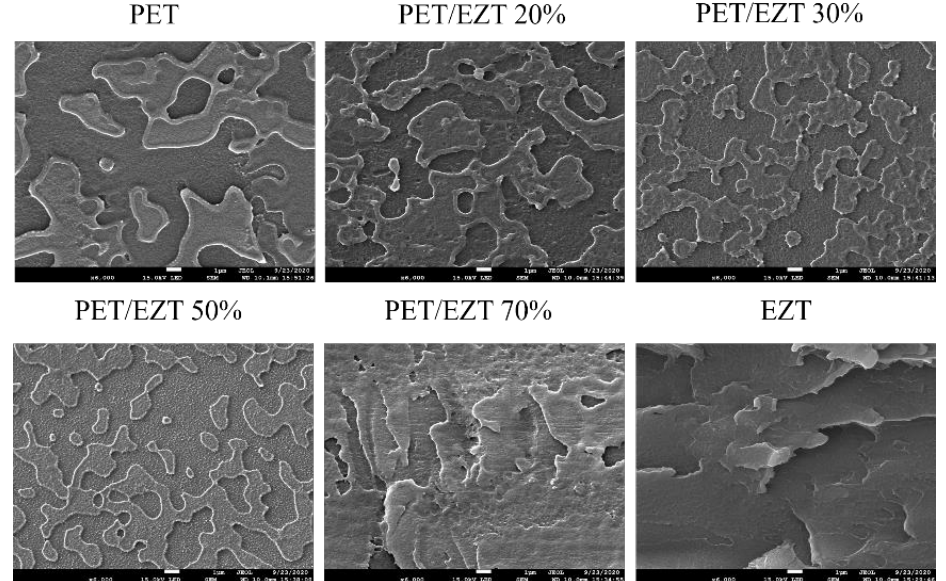
Figure 5. SEM micrographs of the cryo-fractured surface of PET/EZT samples. XRD analysis was performed to identify the crystalline structure of materials. Gen- erally, crystalline polymers represent a series of sharp peaks in the XRD patterns, and amorphous polymers exhibit a relatively broad halo. In contrast, semi-crystalline poly- mers show a superposition of crystalline reflections on an amorphous halo [48]. The XRD patterns of pristine PET, pristine EZT, and PET/EZT samples are shown in Figure 6. The pristine PET sample exhibited a characteristic broad peak and a weak peak at a diffraction angle (2θ) of 20.53° and 43.16°, which corresponded to the amorphous phase of the un- stretched PET sheet. This may have been related to a rapid cooling rate during the sheet forming process (injection molding). Therefore, long molecule chains did not have suffi- cient time to rearrange to form a crystalline phase at low temperatures. The pristine EZT sample also exhibited a broad halo corresponding to its completely amorphous structure. All PET/EZT samples showed a diffraction pattern similar to that of the pristine PET and pristine EZT samples. This indicates that the introduction of EZT into PET does not change the XRD pattern of PET. However, as the content of EZT increased, the characteristic peak shifted slightly to a low diffraction angle. This implies that the interlayer spacing of the PET chain slightly increased (lose of crystallinity), which could be related to transesterification reaction